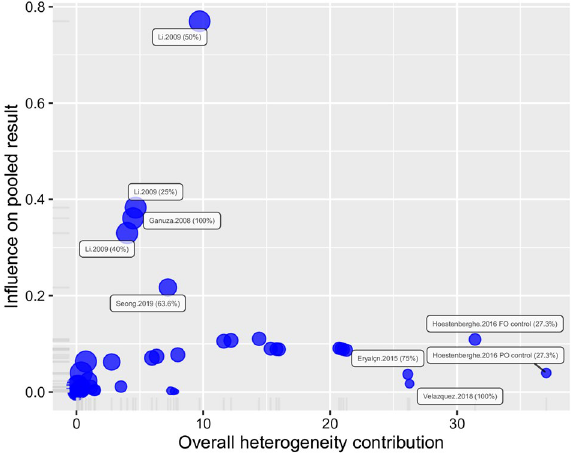
Figure 9. Baujat bubble plot used to identify potential outliers in the Schizochytrium data set, showing the contribution of each study to the overall heterogeneity and its influence under a random effects model. The size of each point is proportional to its relative weight in the meta-analysis. One trial in the upper left corner was overly influential which merited further scrutiny.